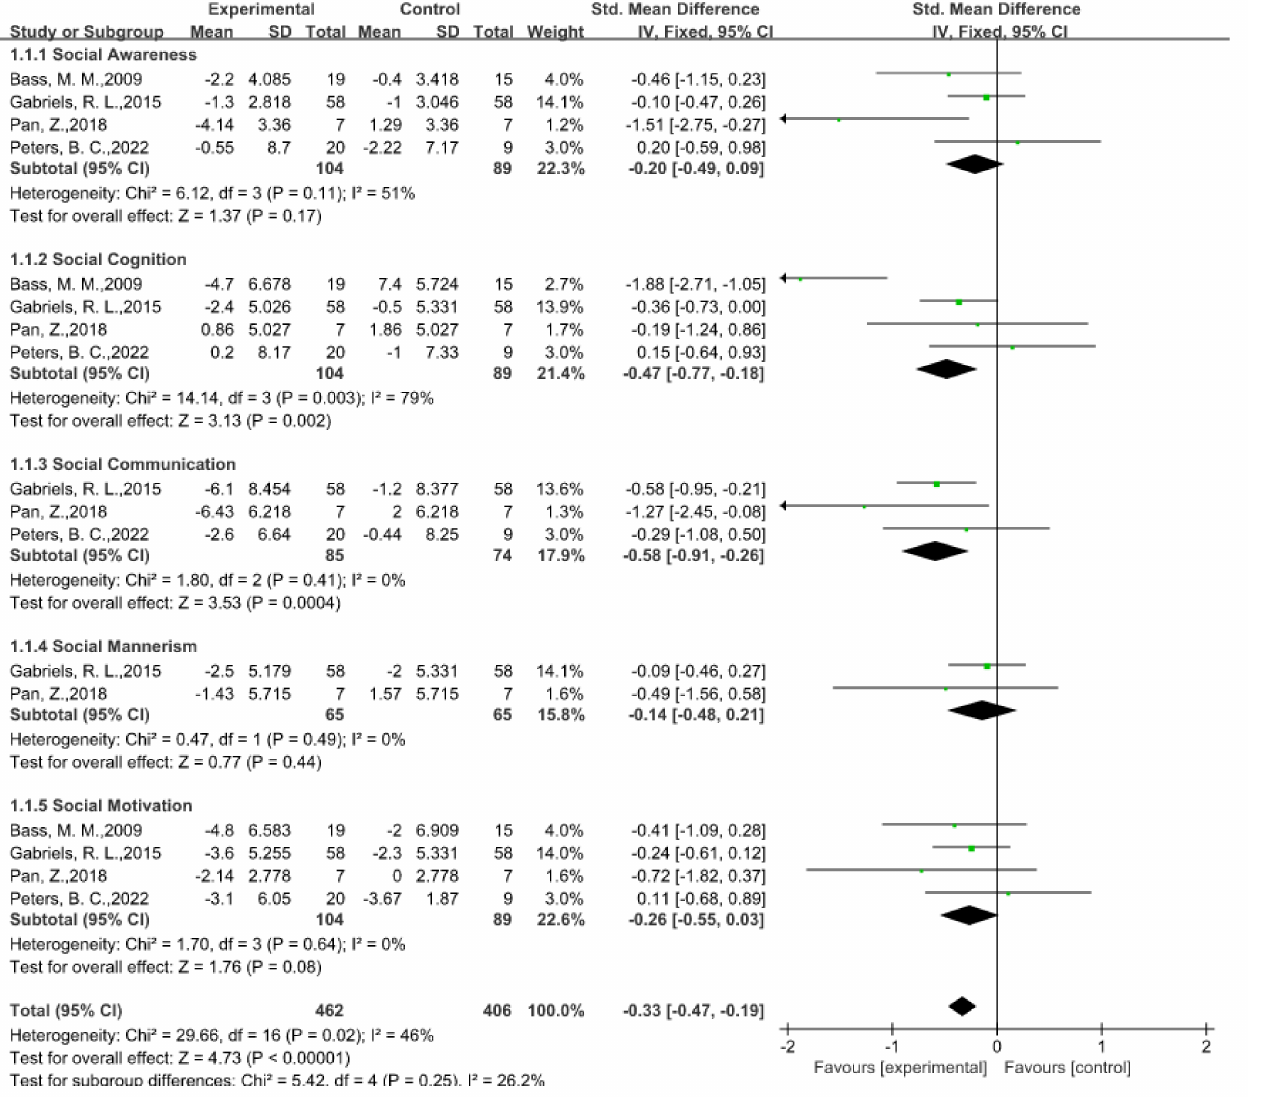
Figure 3. Forest plot of social function using SRS